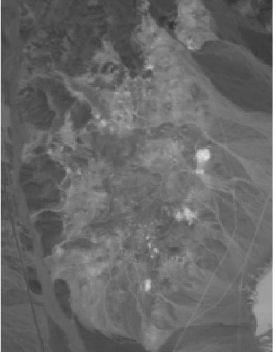
Figure 16. Subimage of AVIRIS Cuprite data (band 80).